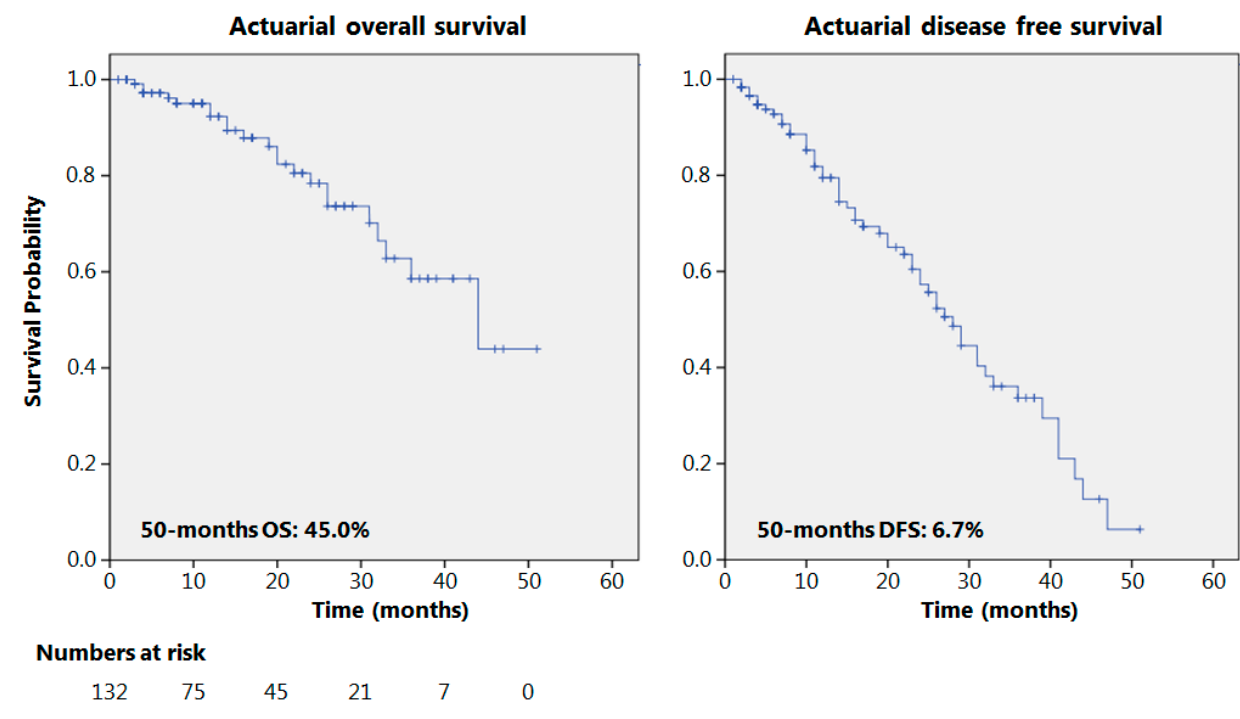
Figure 1. Overall and disease-free survival. Table 3. Oncological results of current